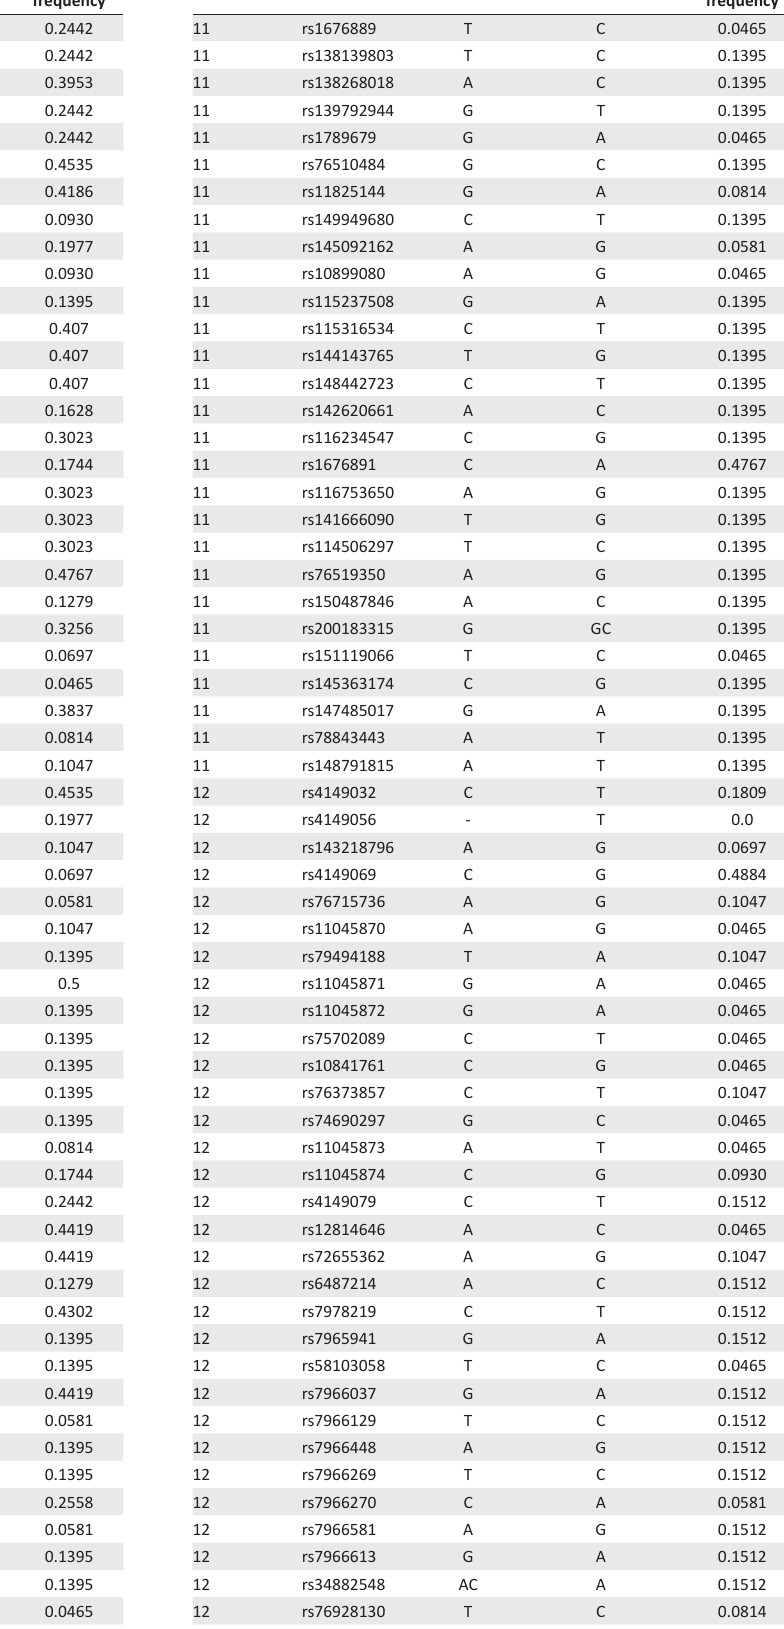
Table 1-A1 (Continues...): Minor allele frequencies for 1846 polymorphisms in 43 black South Africans. Chromosome Polymorphism Minor allele